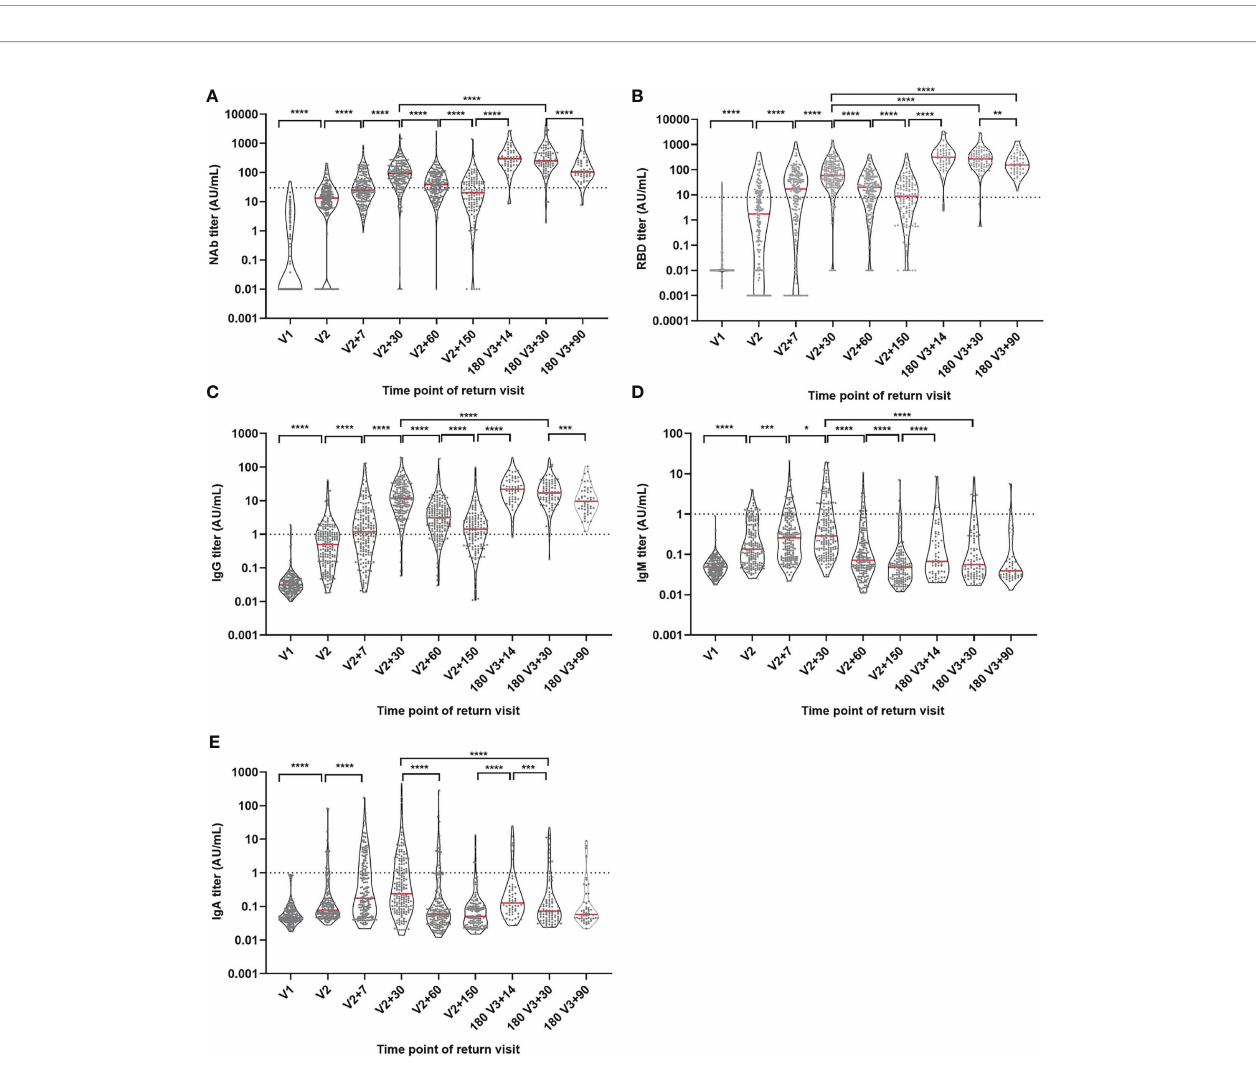
FIGURE 2 | Antibody titer levels at different time points during vaccination. (A) NAb antibody level. (B) RBD antibody level. (C) IgG antibody level. (D) IgM antibody level. (E) IgA antibody level. Red lines: median titer. Dotted lines: manufacturer-de fi ned positive threshold values. *P ≤ 0.05. **P ≤ 0.01. ***P ≤ 0.001. ****P ≤ 0.0001 (Mann-Whitney U test).